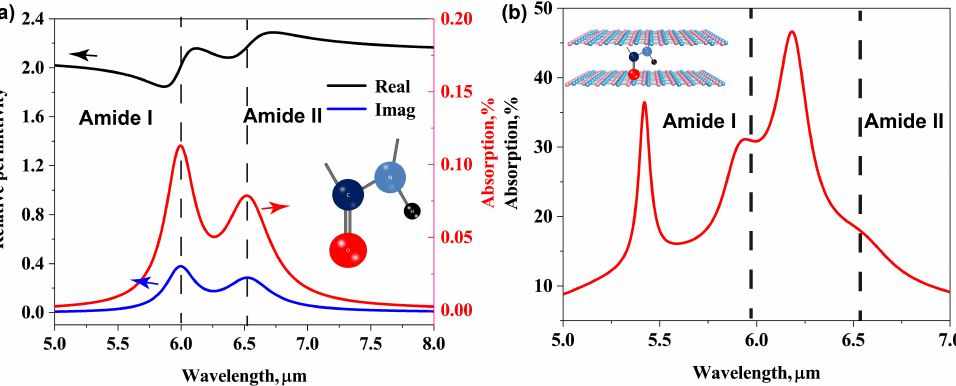
Figure 3. ( a ) Real and imaginary parts of the relative permittivity of this protein are shown as black and blue curves, respectively. The red line show the absorption of 3nm thickness protein molecules coated above losses dielectric substrate (refraction index n = 1.4 and thickness h = 200 nm). ( b ) The absorption spectrum of the bilayer AGP system after placing protein molecules inside plasmon